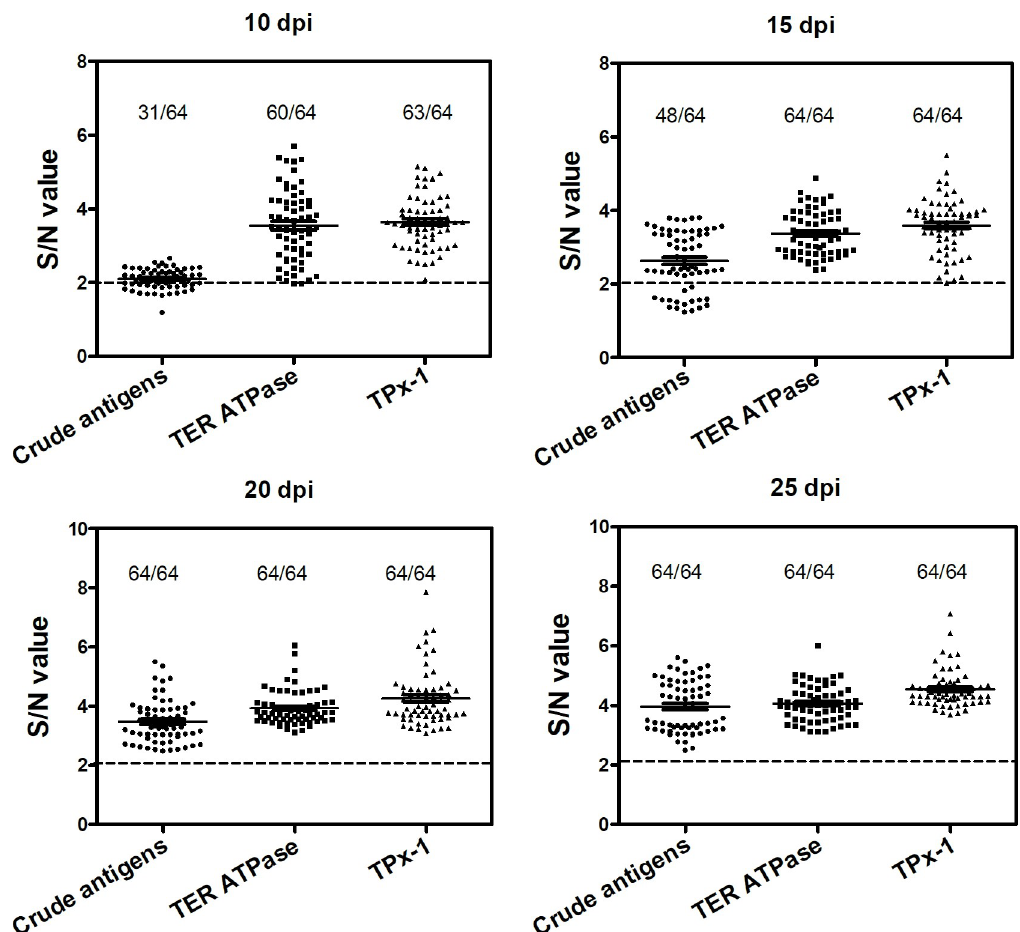
Fig 3. The early diagnostic values of TPx-1 or TER ATPase in E . multilocularis -infected mice using ELISA. For each antigen, the positive cut-off values were calculated by the OD value of each test serum (S) divided by the mean OD value of healthy sera (N). Samples with an S/N value not less than 2 were considered to be positive.